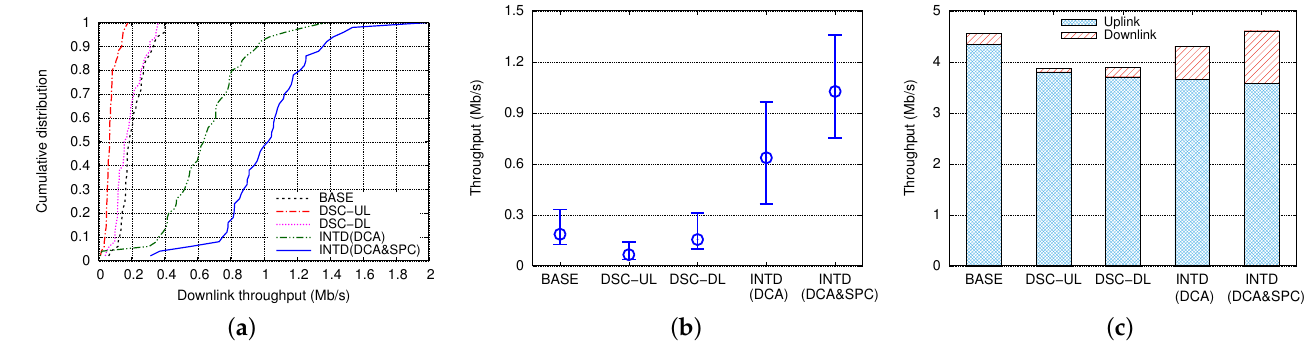
Figure 7. Performance comparison of several mechanisms in terms of ( a ) distribution of downlink throughput; ( b ) median, 10th, and 90th percentiles of downlink throughput; and ( c ) uplink and downlink